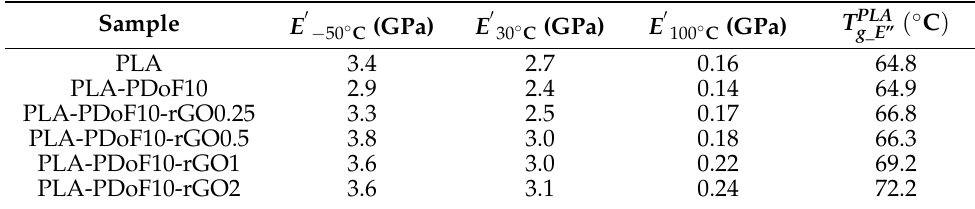
Table 3. Main results of the DMTA tests on the prepared